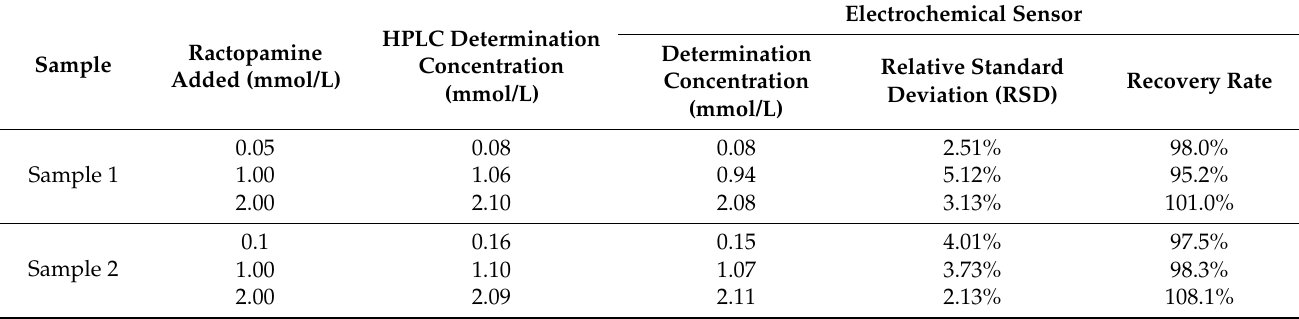
Table 2. Recovery and relative standard deviation (RSD, %, n = 3) of ractopamine in meat by electrochemical sensor and HPLC,